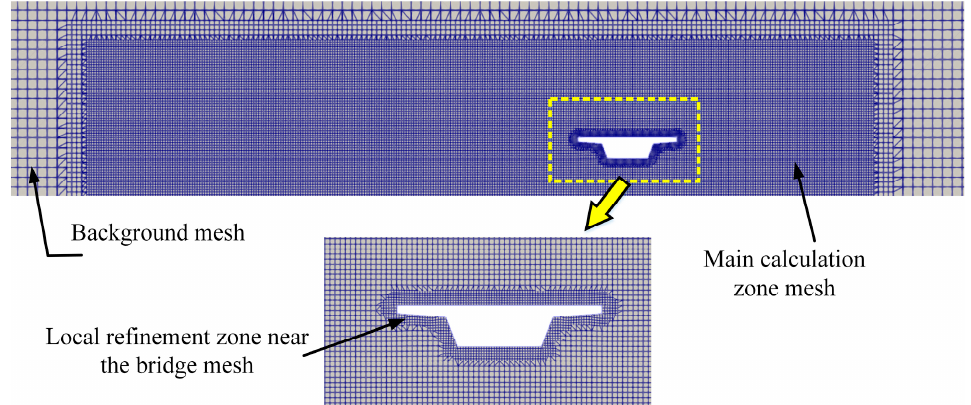
Figure 2. Three di ff erent meshes applied in the numerical model.